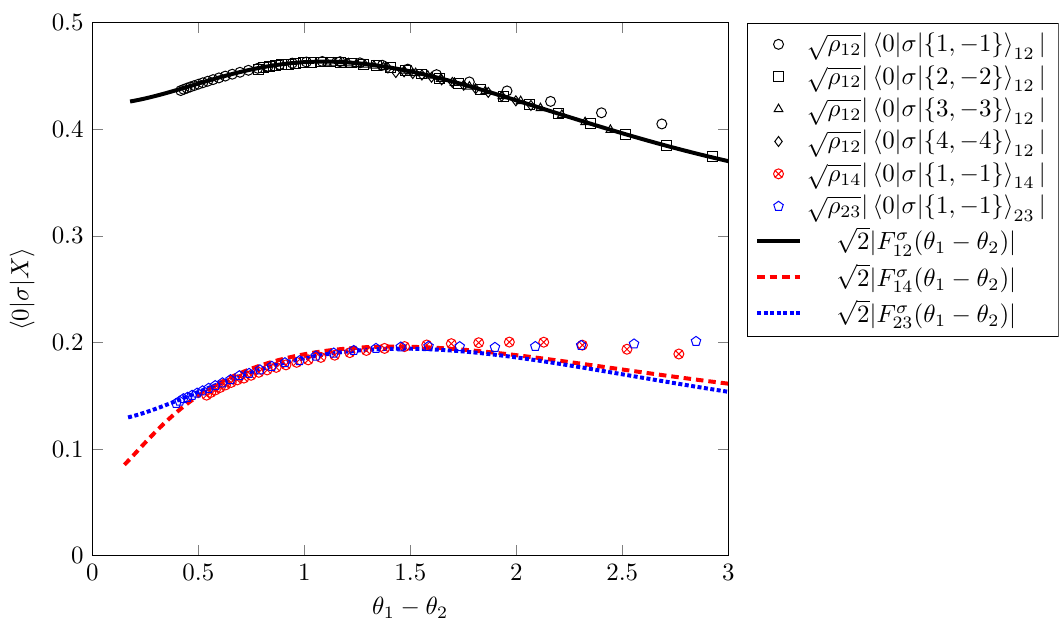
Figure 6.3: Rescaled vacuum-two-particle matrix elements of σ (discrete markers) plotted against the rapidity difference and compared to the exact form factors ob- tained from the bootstrap (shown with lines). Form factors of 12 states of larger quantum numbers are better fit in large rapidities, due to smaller finite size effects. For twp-particle states 14 and 23 states we could only identify the lowest levels for each, since the higher ones are deeply in the continuum of 12 states, which makes their identification